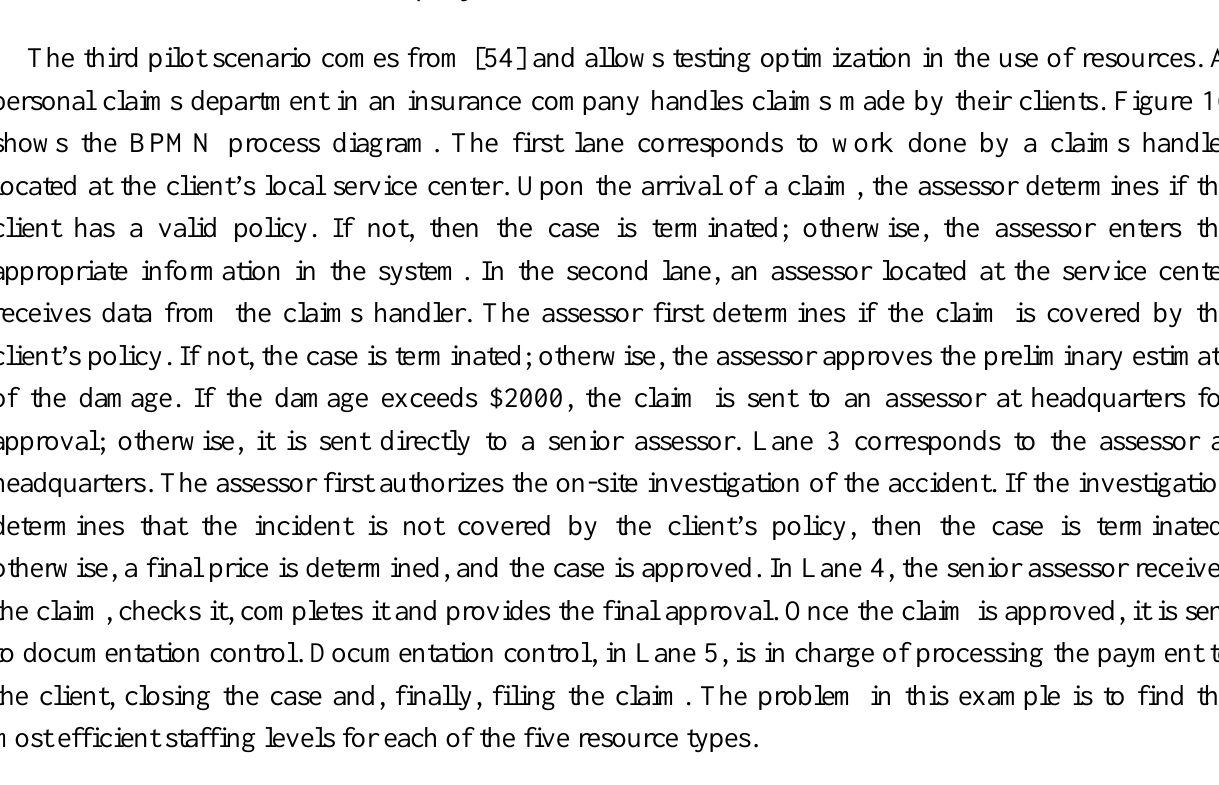
Figure 16. Personal claims process at an insurance company: BPMN process